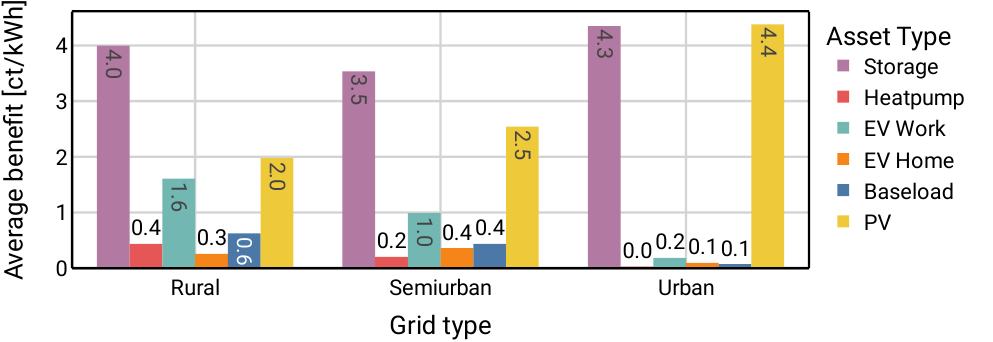
Figure 11. Average asset-specific benefit compared to business as usual for an LEM without a reduction of REPCs for a variety of grid types for the scenario year 2035.